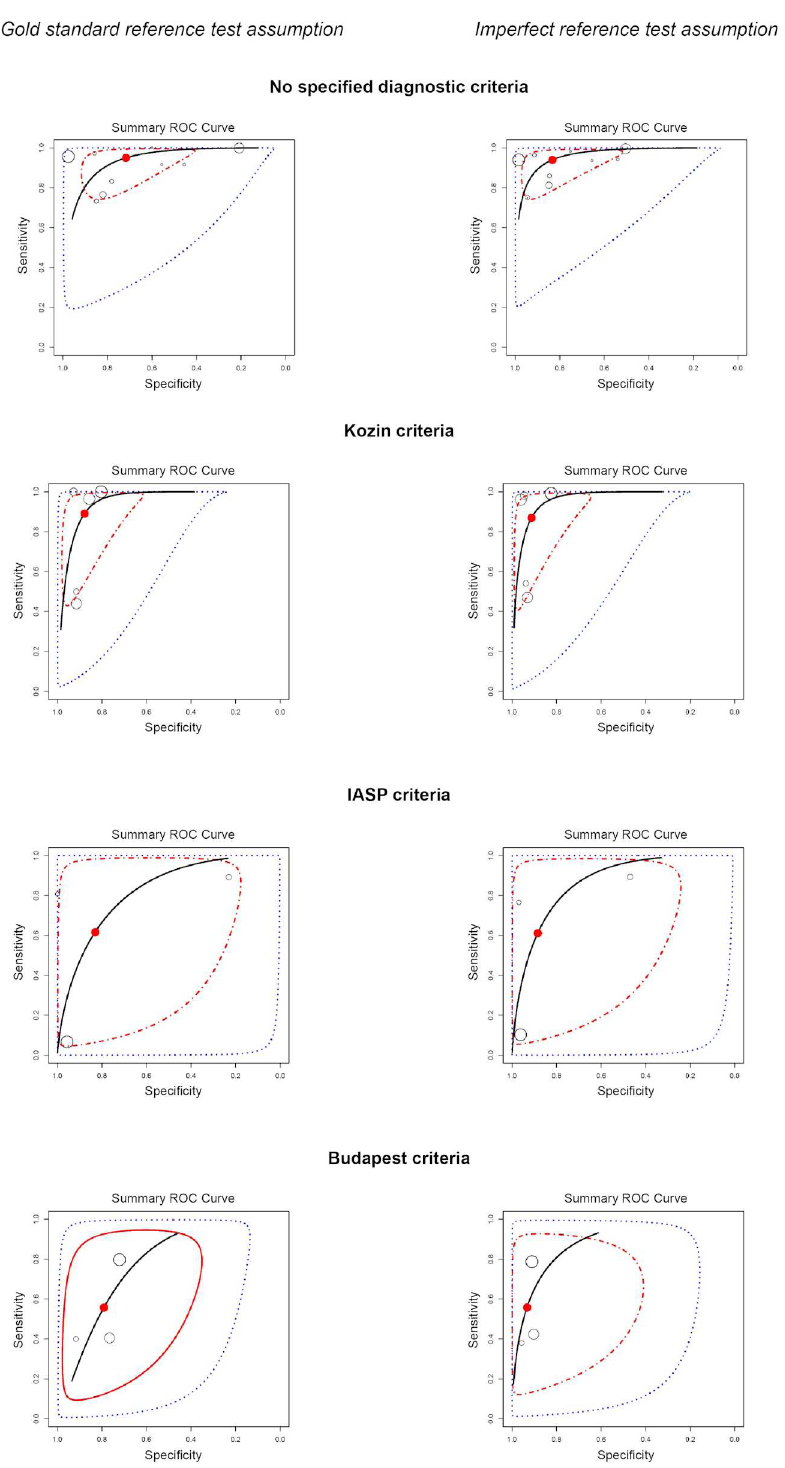
Fig 2. Summary receiveroperating characteristic (ROC) curves for the joint meta-analysis of 21 studies. Results of the joint meta-analysis of 21 studies are presented by the overall posterior sensitivity and specificity with the corresponding95% credibleregion(CI)